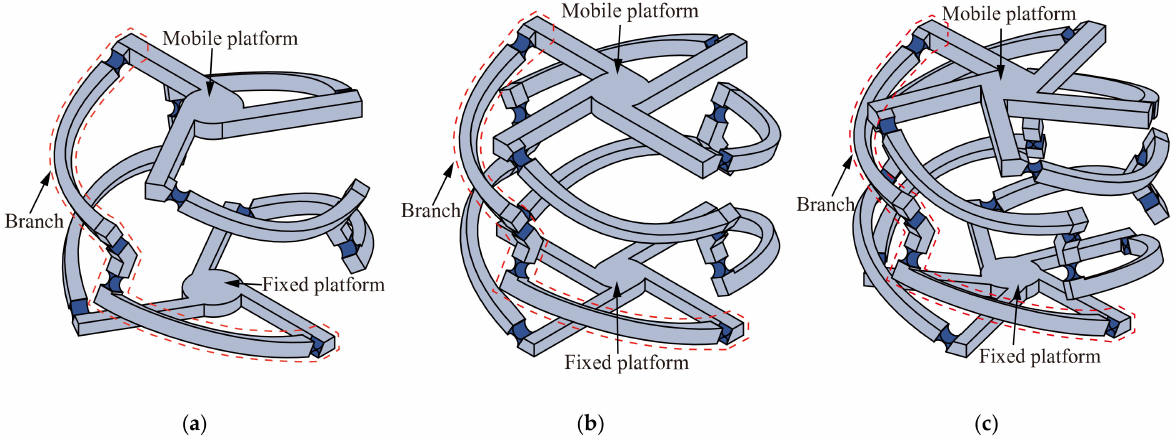
Figure 1. A class of n -4R compliant parallel pointing mechanisms, ( a ) n = 3; ( b ) n = 4; ( c ) n = 5.